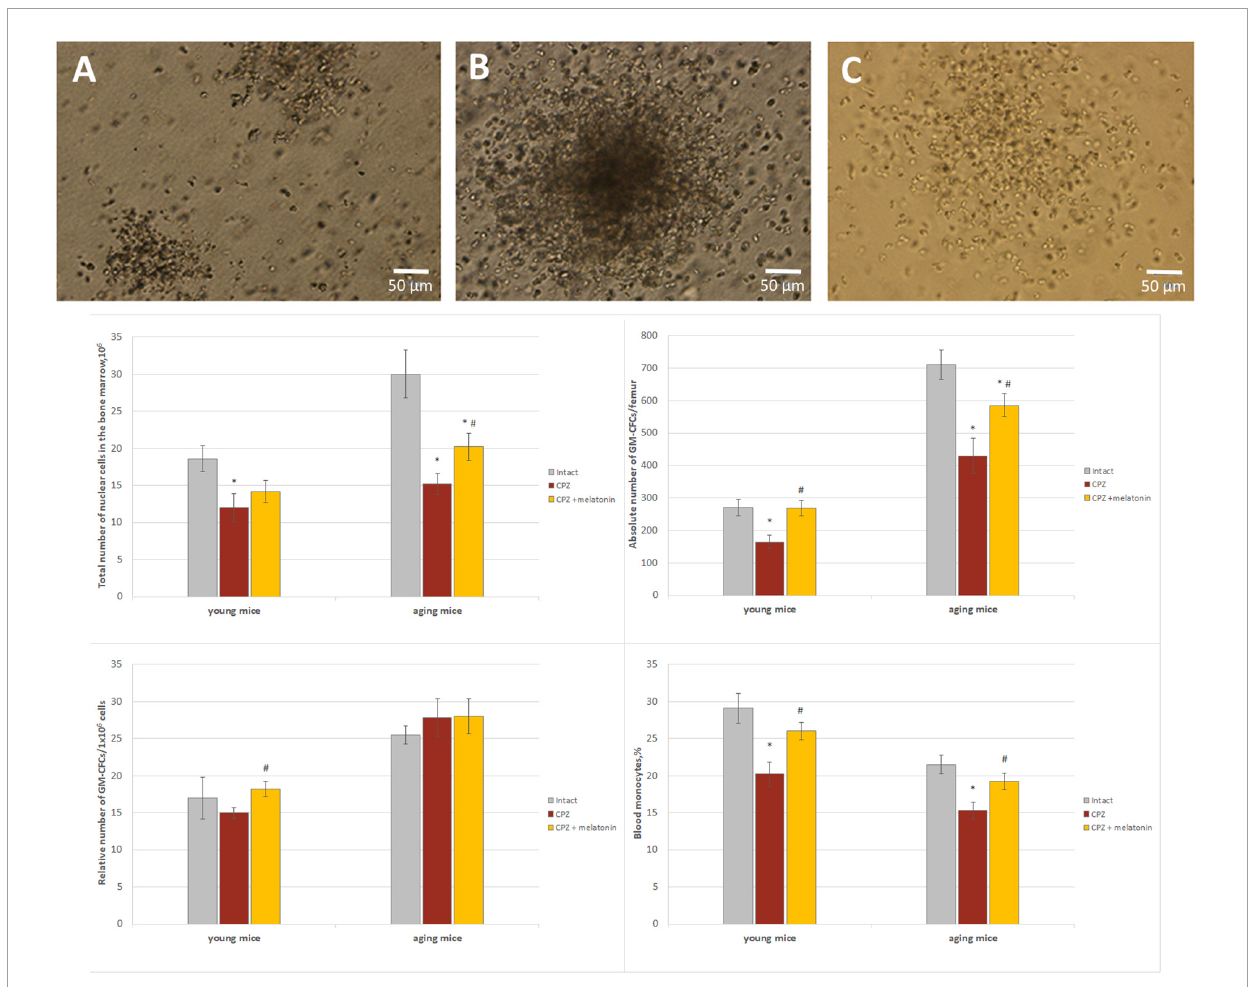
FIGURE9 The number of GM-CFCs in bone marrow and the blood level of monocytes in young and aging mice of experimental groups. For GM-CFCs ( n = 5) for monocytes ( n = 10) from each group of mice. Types of GM-CFCs colonies: (A) granulocytic; (B) mixed; (C) macrophage. Phase contrast. Scale bar, 50 µ m. Represented data are in 3 weeks of CPZ diet. Data are M ± SEM. ∗ p < 0.05 compared to intact group; # p < 0.05 compared to CPZ ( t